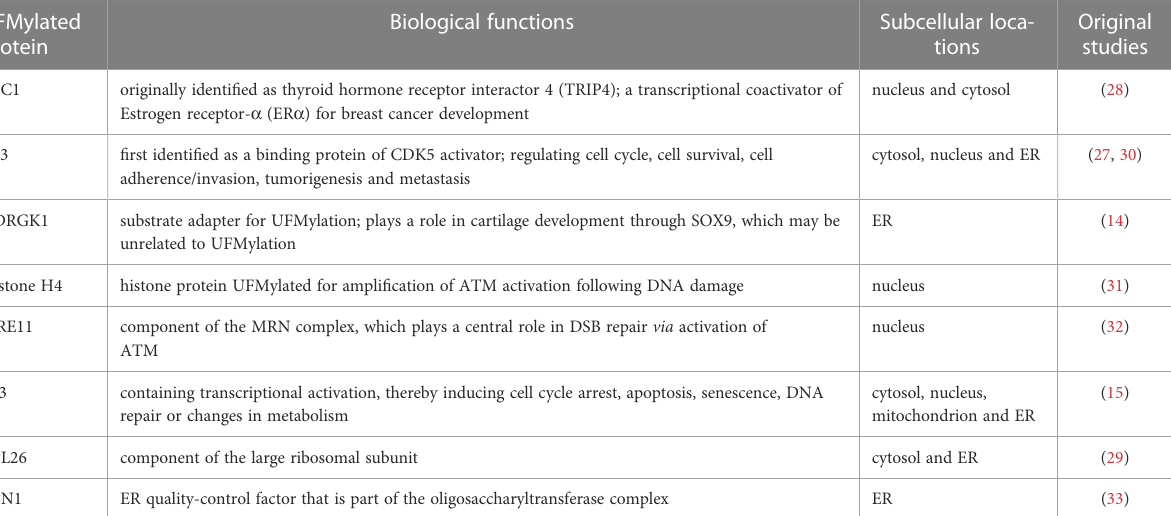
TABLE 1 Well-characterized UFMylation substrates to date.